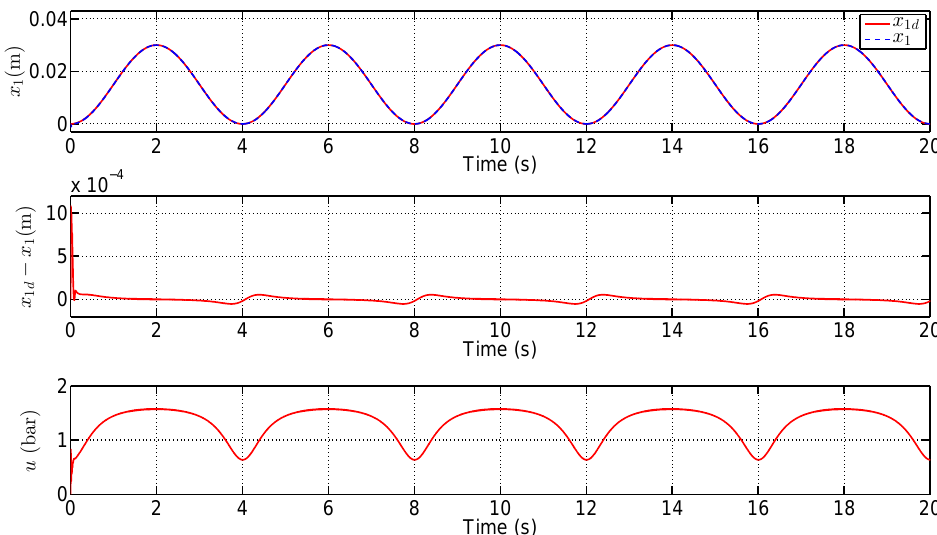
Figure 2. The tracking performance of the proposed method.